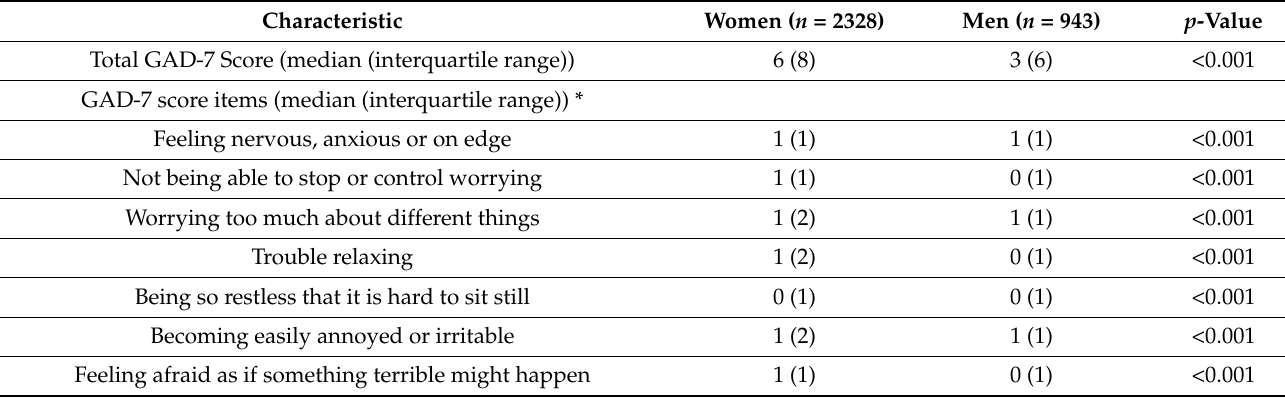
Table 3. Anxiety Measures.